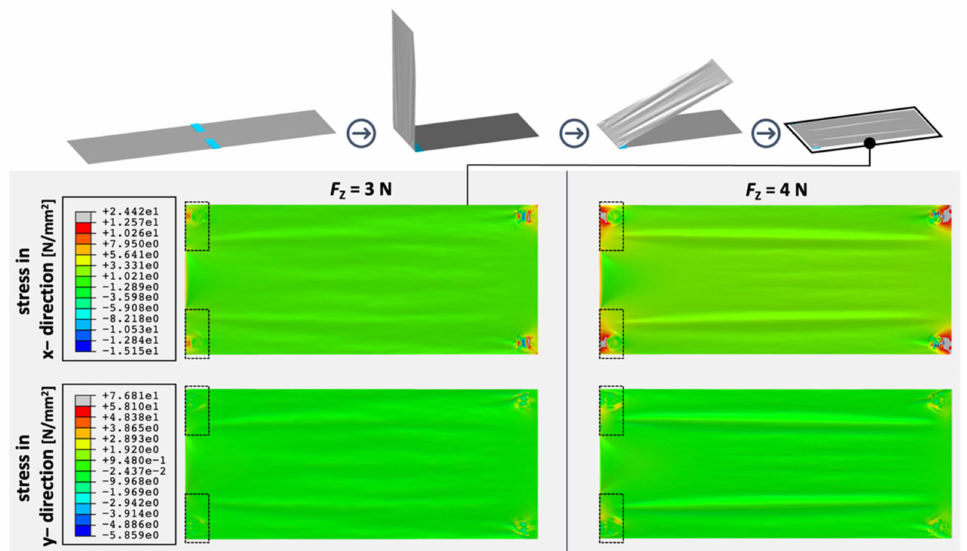
Figure 19. Normal stresses in x- and y-directions at the end of the folding motion for the ceramic separator and different web tension